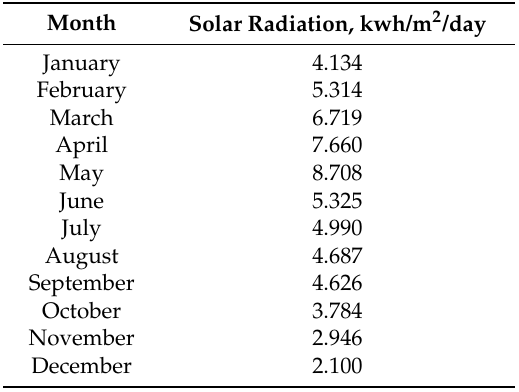
Table 2. Monthly average solar radiation.